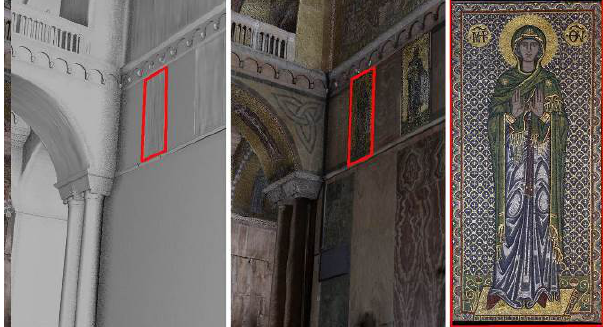
Figure 6: location of orthophoto from 3D NURBS model